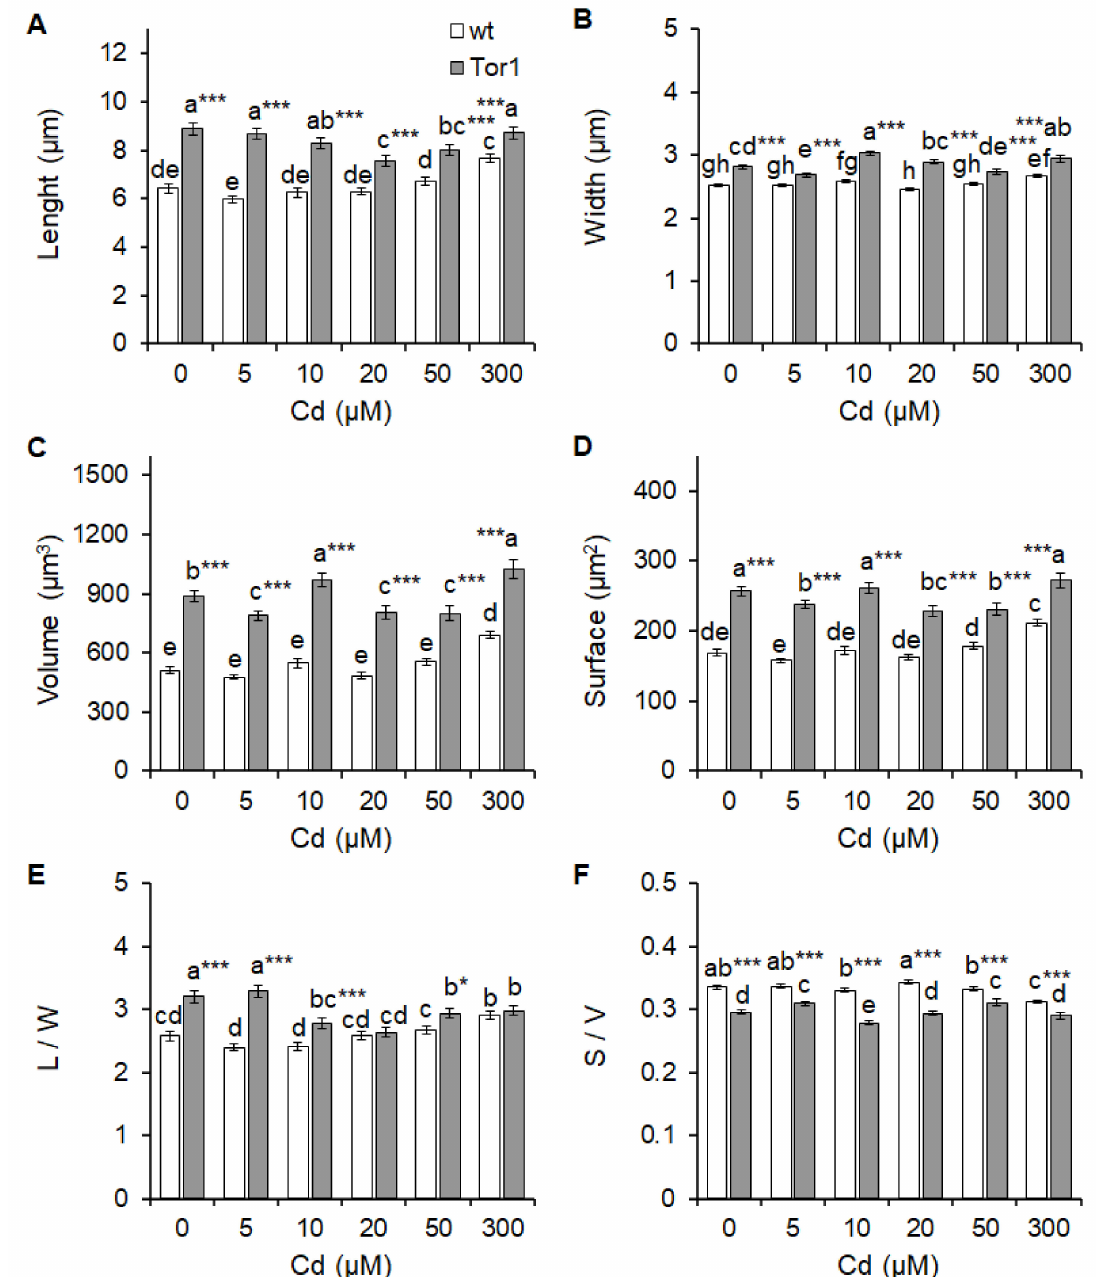
Figure 5. Morphological parameters of the Tor1-depleted and wild-type cells subjected to Cd. Determination of the cell length ( A ) and width ( B ) in µ m of wild-type (wt, white bars) and Tor1-deficient (Tor1, grey bars) cells before and after Cd exposure. Calculation of the cell volume ( C ) in µ m 3 and surface ( D ) in µ m 2 of wt and Tor1 cells represents more objective analyses of shape changes between the wt and Tor1 cells upon Cd exposition. ( E ) Aspect ratio (lenght / width L / W) demonstrates changes in the cell shape and ( F ) the surface / volume (S / V) ratio represents changes in the size of tested cells. Statistical significance is determined by Duncan´s post-hoc test, defined with an asterisk (*) given as p < 0.05 *, 0.01 **, 0.001 ***; bars indicate mean ± SD ( n = 100), and bars with identical letters are not significantly di ff